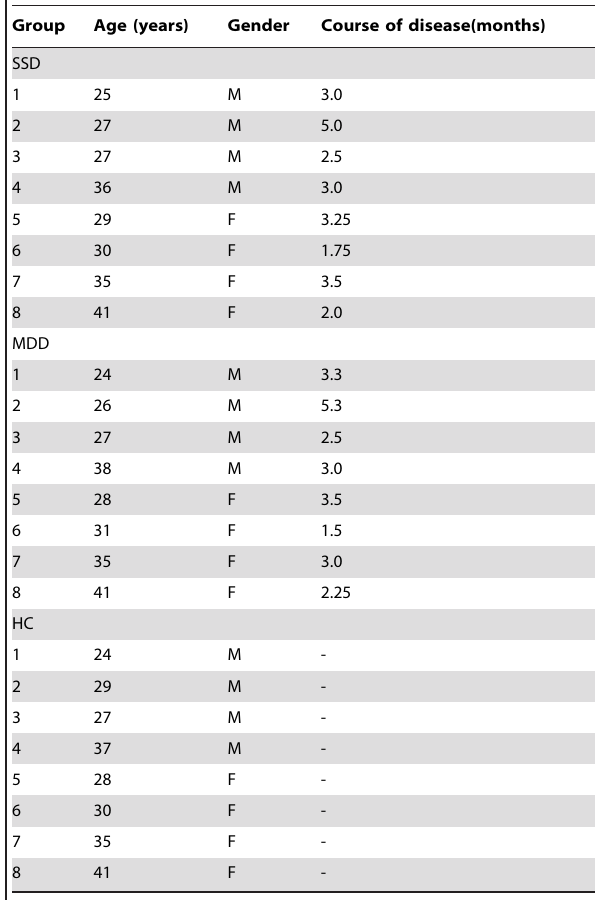
Table 5. Demographic data for patients and healthy controls.